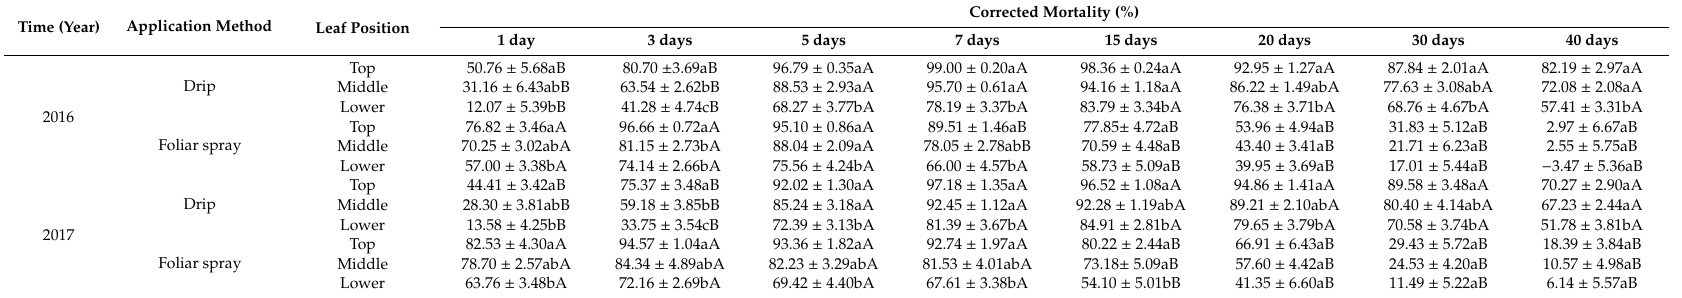
Table 2. Control e ffi cacies of sulfoxaflor to cotton aphid with two application methods in 2016 and 2017 1